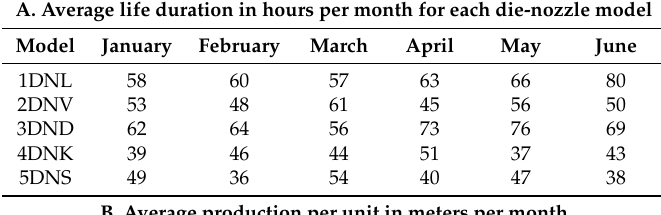
Table 2. Collected data from January to June